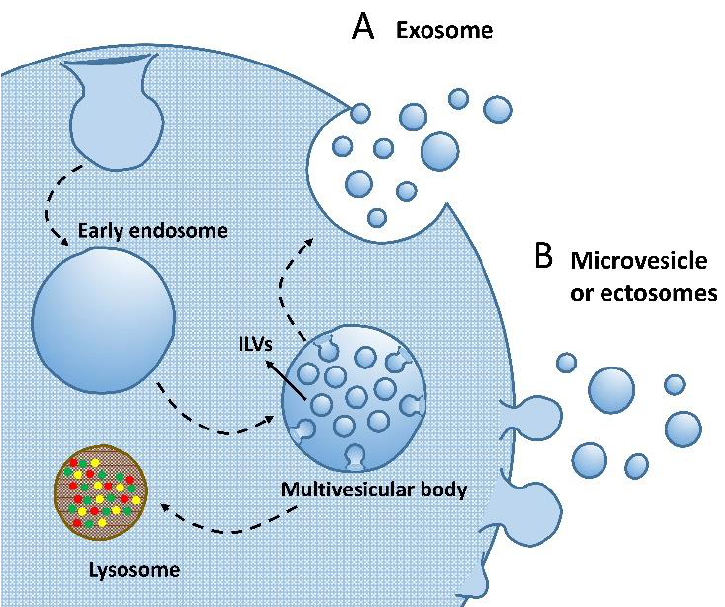
Figure 2. Routes of EV biogenesis. ( A ) Exosome biogenesis depends on the cellular endomembrane system, with the plasma membrane invaginating to form endosomes. Endosomes further mature to multivesicular bodies with intraluminal vesicles (ILVs) enclosed. The multivesicular bodies either go to lysosomes for degradation or fuse to the cell membrane for exosome release. ( B ) Microvesicles or ectosomes directly bud from the cell surface. Both generation machineries may give vesicles with a variable size